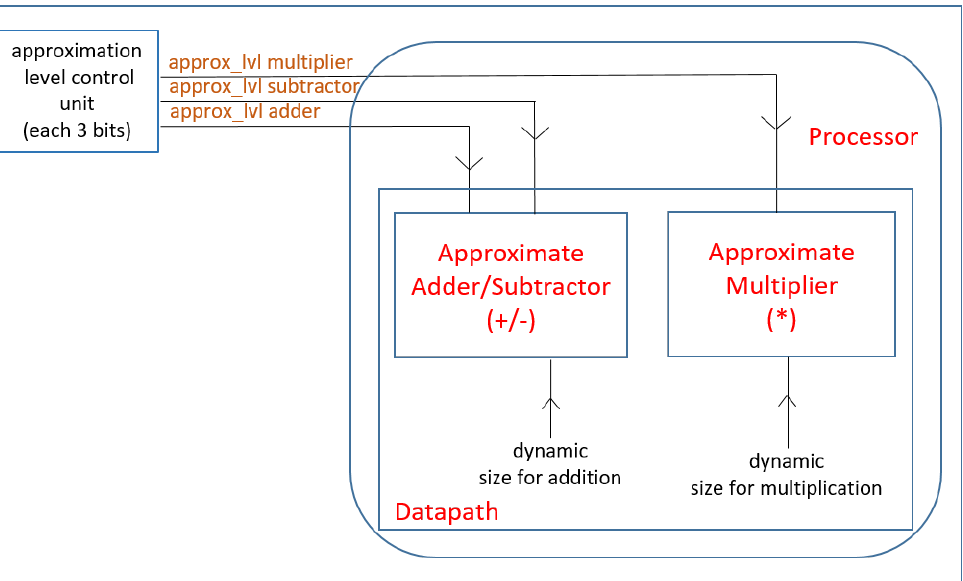
Figure 6. Flow diagram of dynamic control of the approximation levels and dynamic sizing.